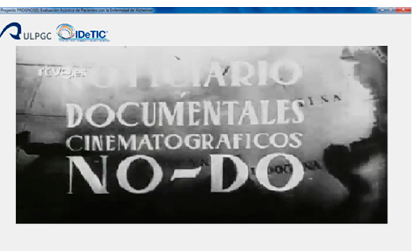
Figure 7. Frame of one of the videos. Newcast NO-DO.